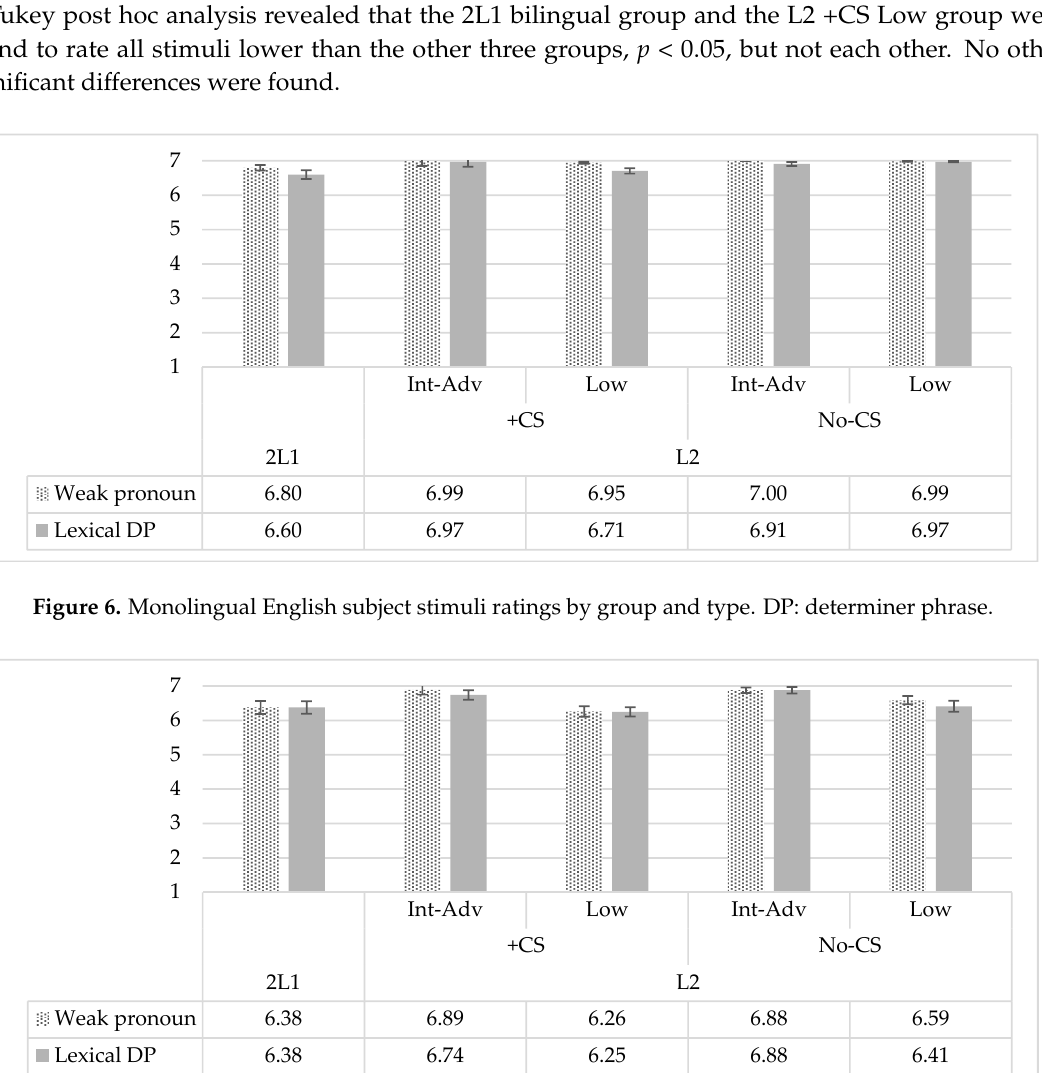
Figure 5. Code-switched Spanish-to-English verb stimuli ratings by group and type.